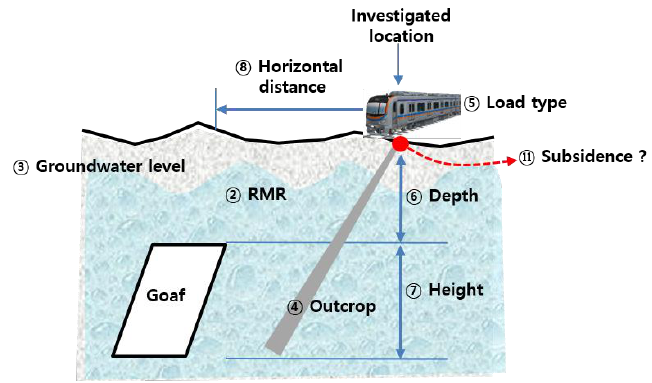
Figure 8. Selected influence factors.